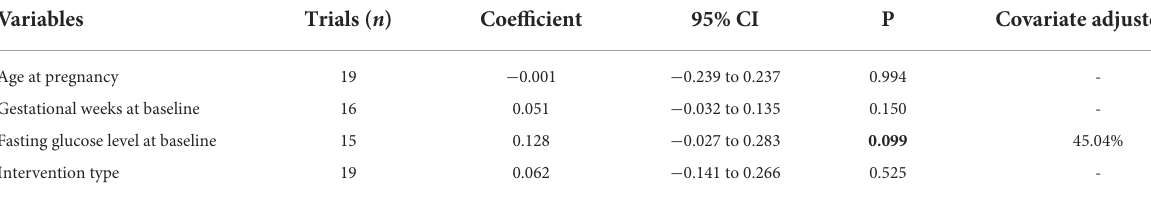
TABLE 3 Meta-regression analysis of potential moderators.